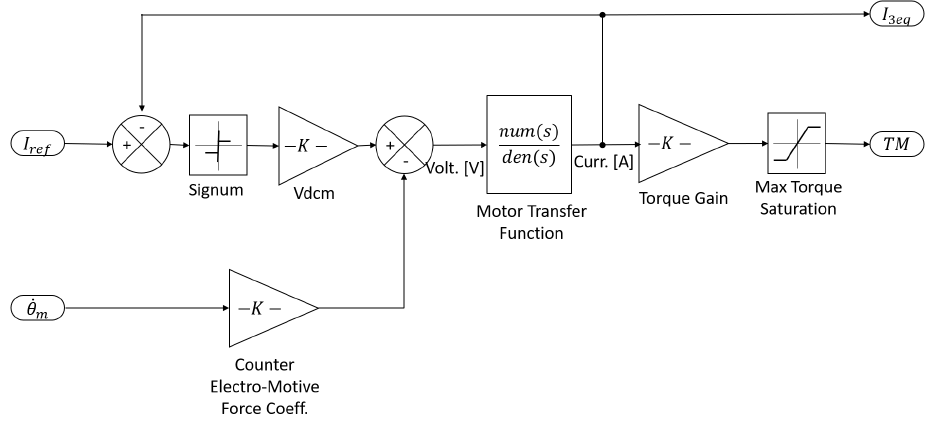
Figure 4. Motor Electromagnetic